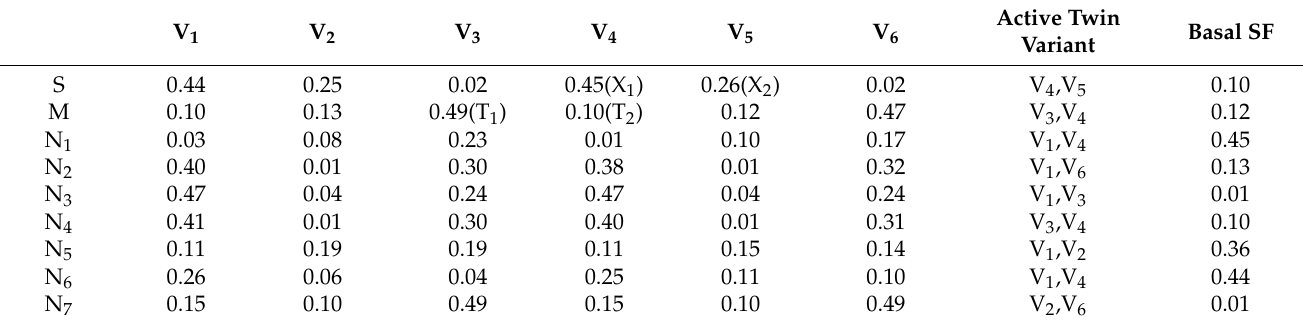
Table 2. Twin variants and their corresponding SFs in the selected grains